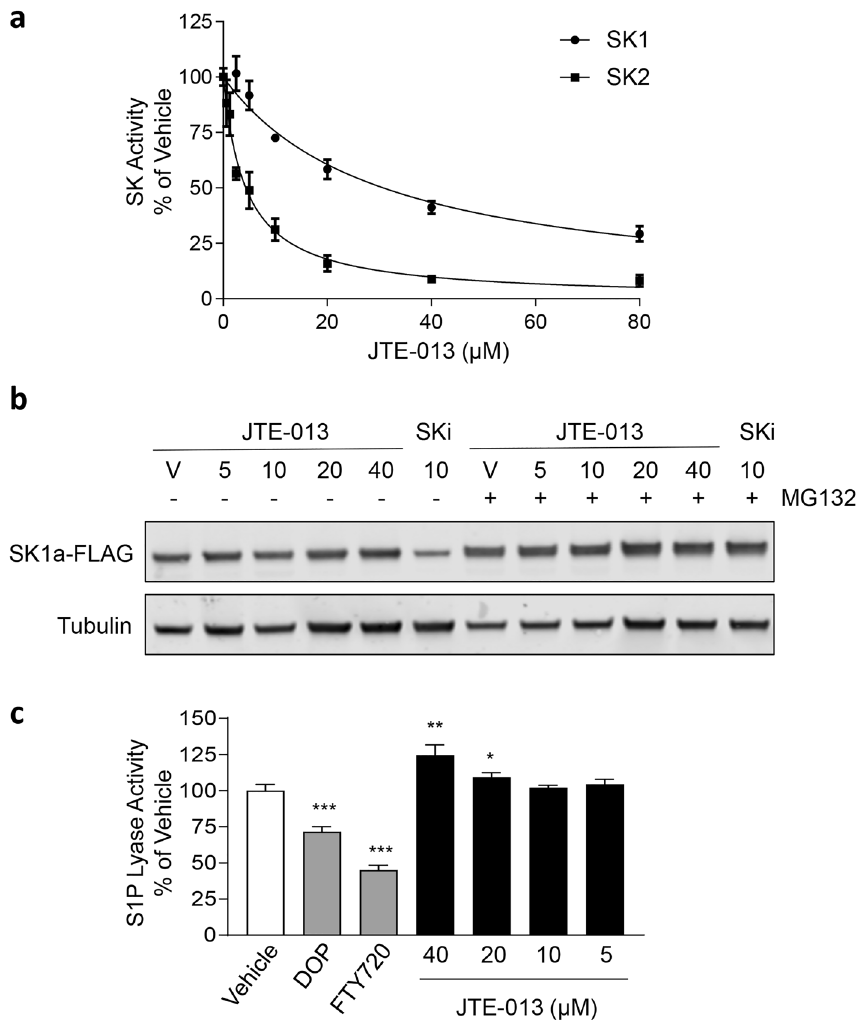
Figure 4. S1P 2 antagonist JTE-013 inhibits sphingosine kinases but not S1P lyase. ( a ) Purified recombinant human sphingosine kinases 1 and 2 were assayed with vehicle (DMSO), or varying doses of JTE-013. Values are shown as % activity compared to vehicle control. Lines indicate non-linear regression curve fitting (GraphPad Prism). Results represent mean ± SEM from three independent experiments performed in duplicate. ( b ) Western blots show the effect of varying concentrations of JTE-013 (5–40 μM) or 20 μM SKi for 24 h compared to vehicle (V) treatment in the presence or absence of 10 μM MG132 on SK1a-FLAG in HEK293 cells (upper panel). 1.25 mM 4-deoxypyridoxine (DOP), 25 µM FTY720, or varying doses of JTE-013. Values are shown as % activity compared to vehicle control and represent mean ± SEM (n = 3). Statistical significance was